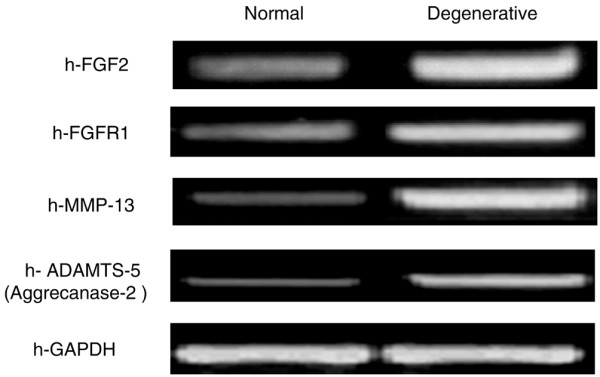
Comparison of endogenous gene expression by cells from normal and degenerative human intervertebral disc. Fresh human nucleus pulposus tissue from normal (grades 0 to 2) and degenerative (after surgery) intervertebral disc cells were subjected to total RNA preparation followed by semiquantitative RT-PCR using human specific primer sets. Glyceraldehyde 3-phosphate dehydrogenase (GAPDH) was used as the internal control. FGF2, fibroblast growth factor 2; FGFR, fibroblast growth factor receptor.